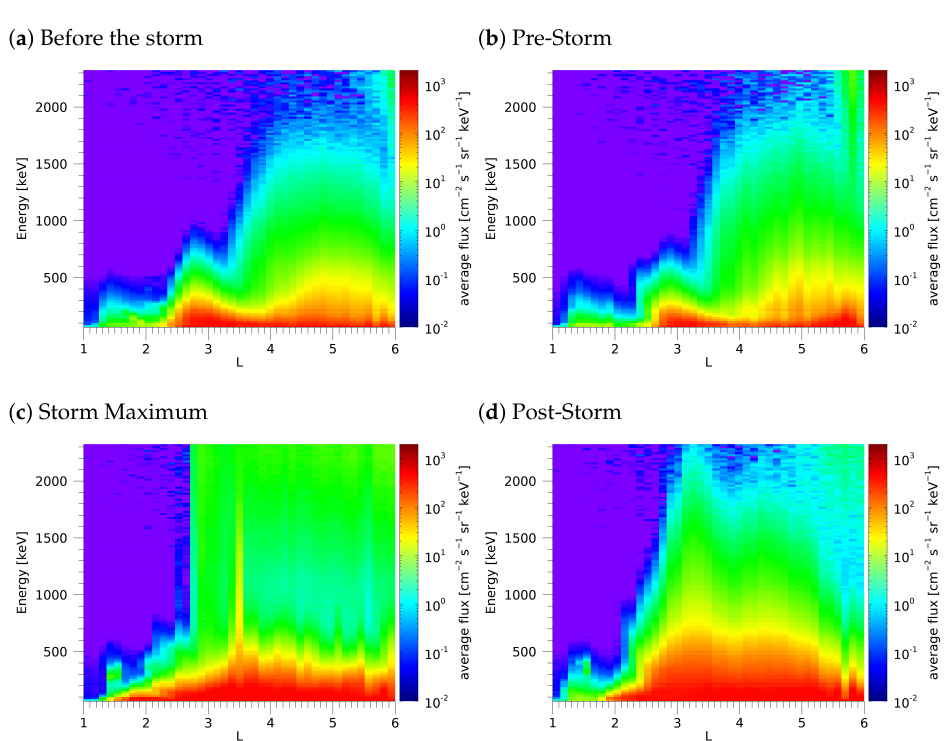
Figure 5. Average energetic particle fluxes during Type 1 storms are color-coded as a function of energy (ordinate) and L-shell (abscissa) during four selected two-hour-long time subintervals. ( a ) One day before the Dst minimum. ( b ) Around the Dst maximum just before the storm onset. ( c ) Around the Dst minimum. ( d ) One day after the Dst minimum.